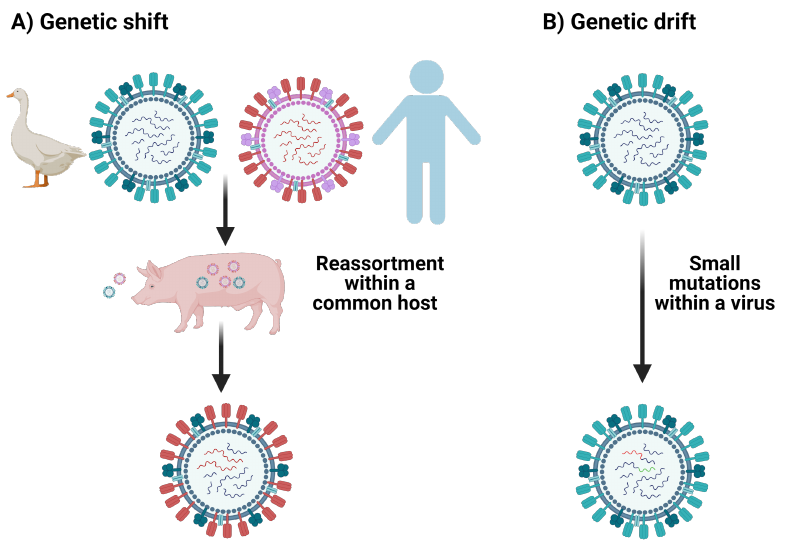
Figure 4. Mechanisms of mutation of influenza viruses. ( A ) The swapping of gene segments between influenza viruses via reassortment in a common host, illustrating genetic shift. ( B ) Small mutations gained from error-prone replication illustrating genetic